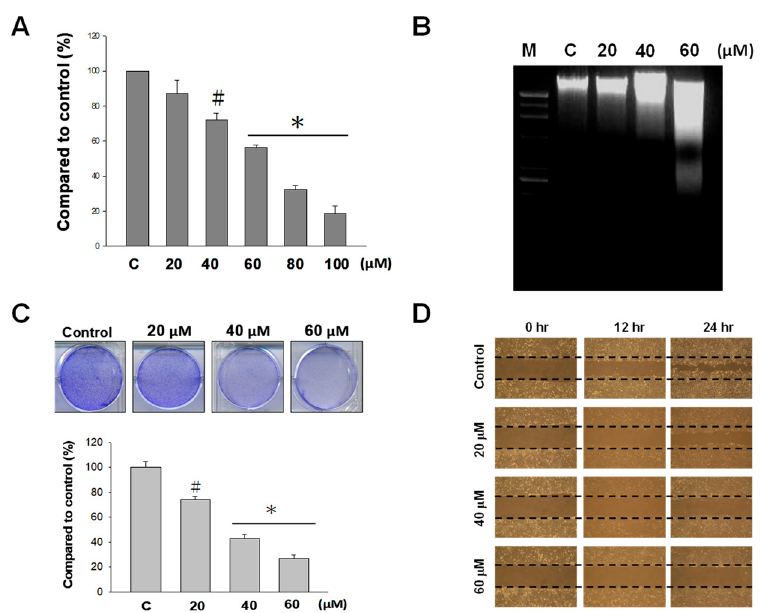
Figure 1. Effect of nobiletin (NOB) on cultures of BFTC bladder cancer cells. ( A ) BFTC cells were treated with NOB (20–100 μ M) for 24 h, and the cytotoxic effect of NOB was analyzed by MTT assay. ( B ) DNA fragmentation caused by NOB treatment (20–60 μ M) was detected via electrophoretic DNA